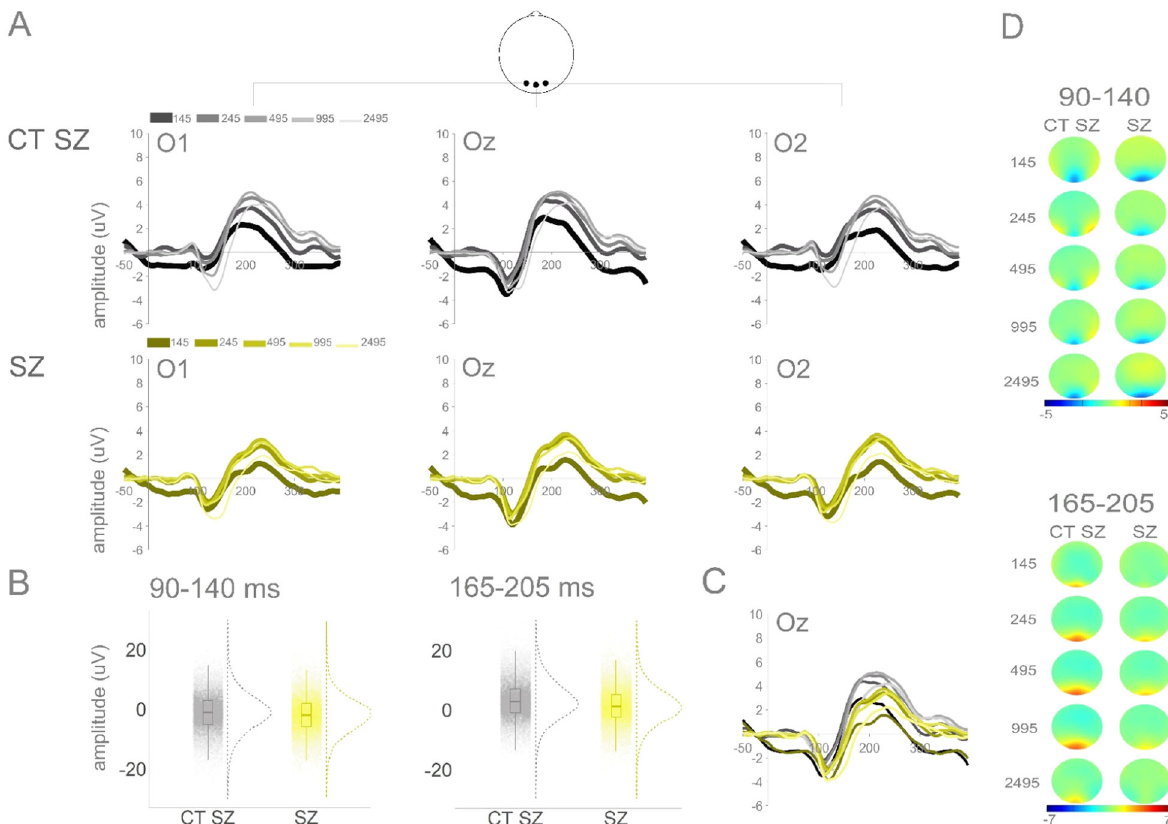
Fig. 4 CT SZ and SZ: Averaged ERPs and topographies per group and ISI. A Averaged ERPs per group (CT SZ and SZ) and ISI at O1, Oz, and O2. B Plots showing distribution of amplitudes (trial-by-trial data; average of O1, Oz, and O2) for the time windows of interest (90 – 140 ms and 165 – 205 ms). C Averaged ERPs for both groups at Oz. D Topographies for windows of interest per group and